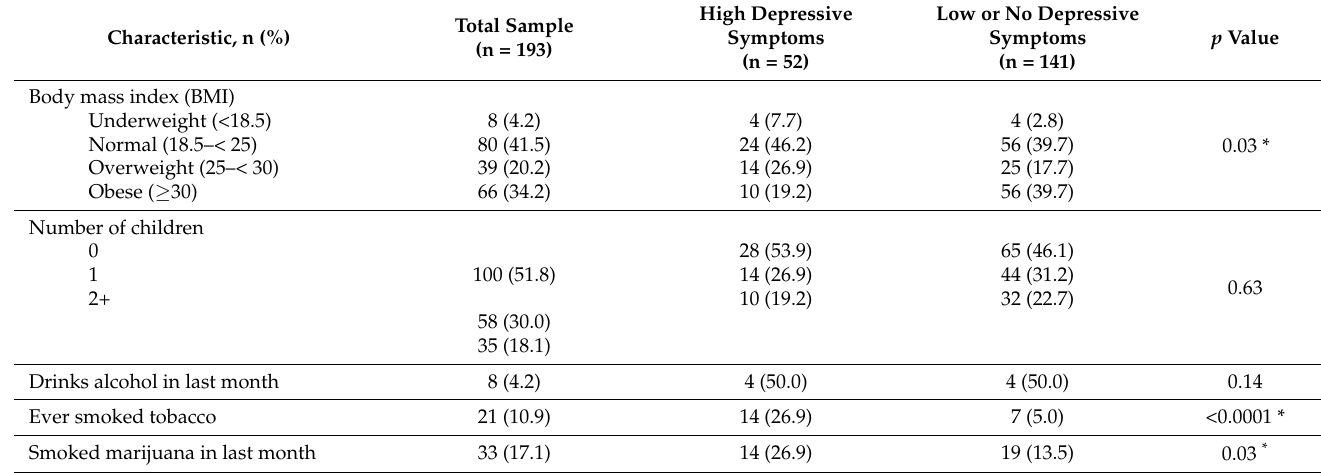
Table 2. Health-related characteristics of African American women by high and low or no depressive symptoms (using EDS cutoff ≥ 10).